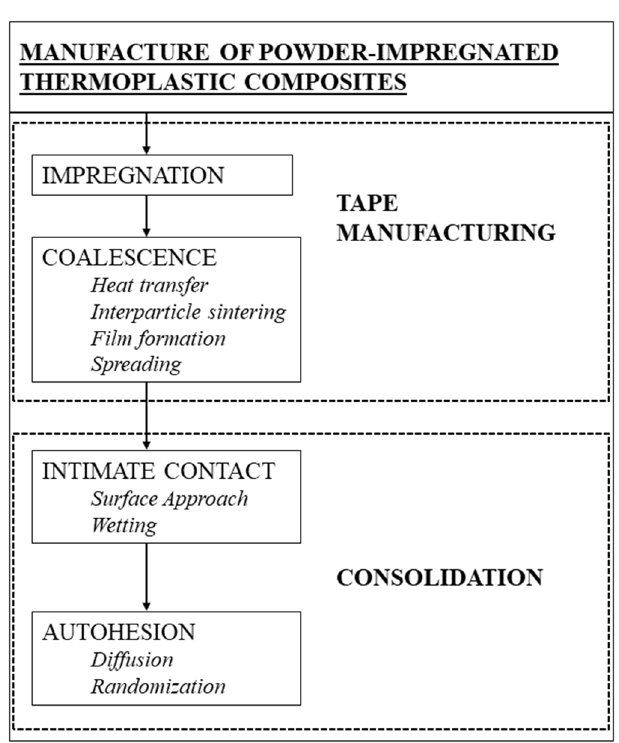
Figure 8. Flowchart for the manufacture of powder-impregnated thermoplastic composites. Authors’ own figure from Reference [6].